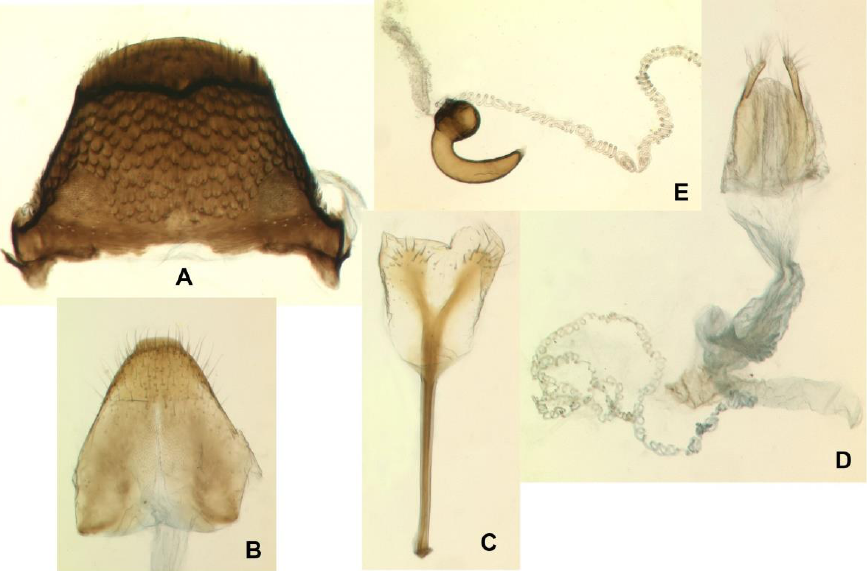
Figure 15. Euryommatus mariae adult female. ( A ) Tergite VII; ( B ) tergite VIII; ( C ) spiculum ventrale; ( D ) ovipositor, vagina, bursa copulatrix, and major portion of spermathecal duct; ( E ) spermatheca with its gland and adjoining portion of the broken spermathecal duct.